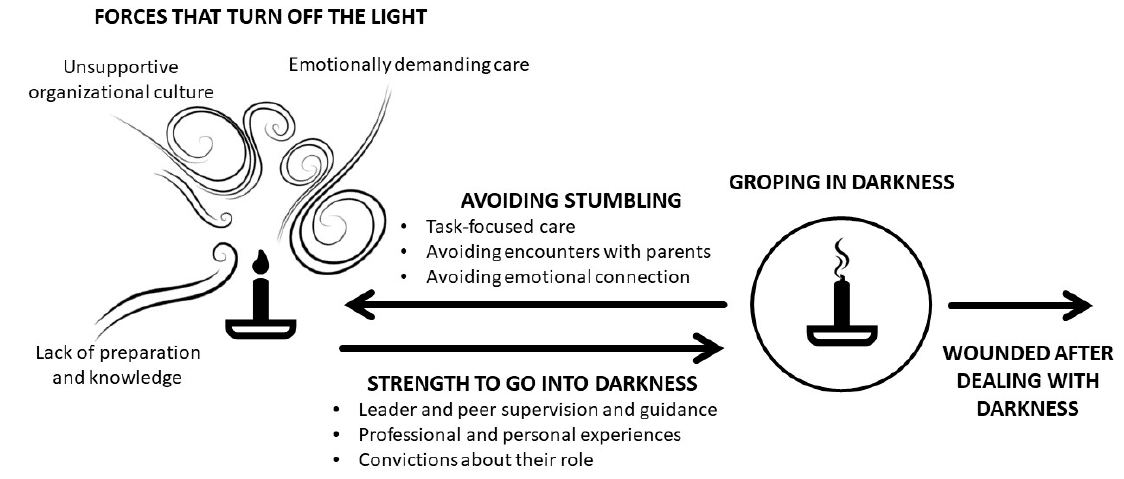
Figure 2. Caring in darkness.